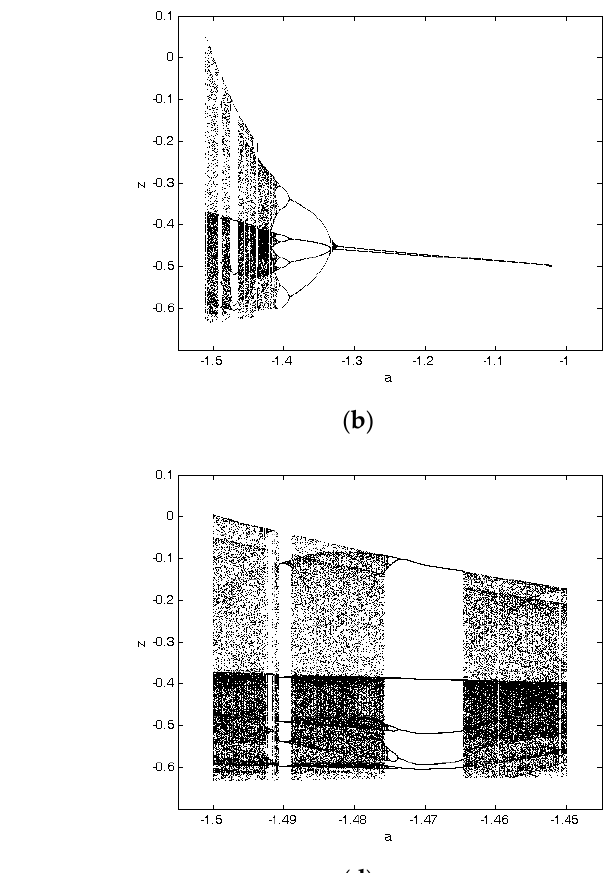
( ) ( ) ty versus a ; and ( b , d ) tz versus a , generated by computer solution of the Figure 5. Bifurcation diagrams: ( a , c ) Figure 5. Bifurcation diagrams: ( a , c ) y ( t ) versus a ; and ( b , d ) z ( t ) versus a , generated by computer solution of the system (1) system (1) at at b = 0.5. The initial conditions are x ( 0 ) = y ( 0 ) = z ( 0 ) = 0.1. Note that a ∈ [ − 1.51, − 1.03 ] .